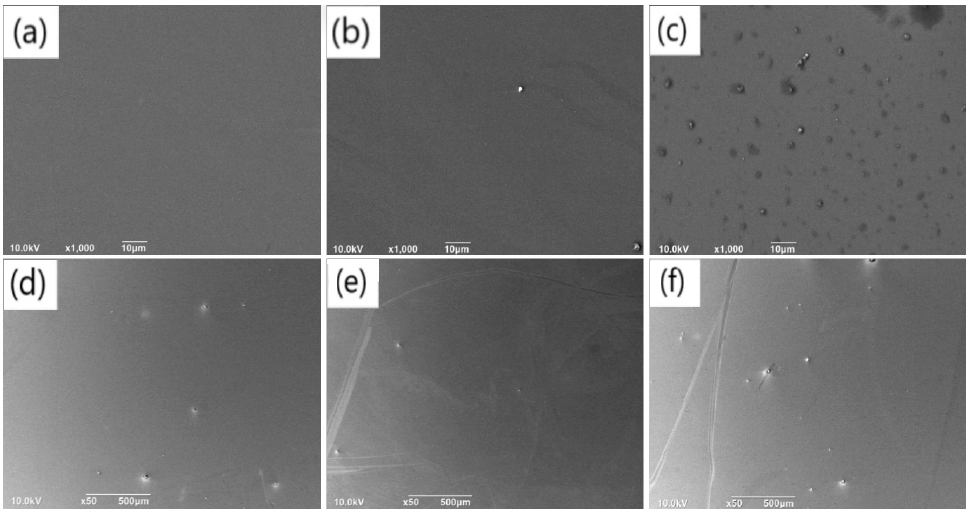
Figure 4. SEM images (1000 × ) showing the surface of the PDA films with the same thickness deposited for different duration on silicon dioxide substrates under the conditions of ( a ) pH = 7.9, ( b ) pH = 8.2 and ( c ) pH = 8.5; 50 × SEM images of the surface of the above-mentioned films corresponding to ( d )pH = 7.9, ( e ) pH = 8.2, and ( f ) pH = 8.5, respectively.